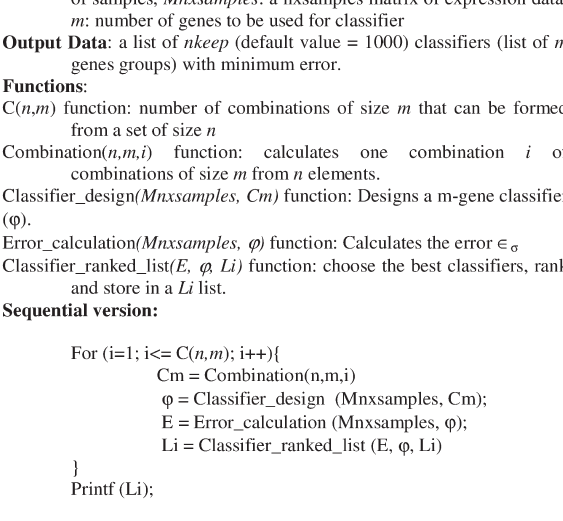
Figure 2 - Pseudo-code of GCLASS sequential